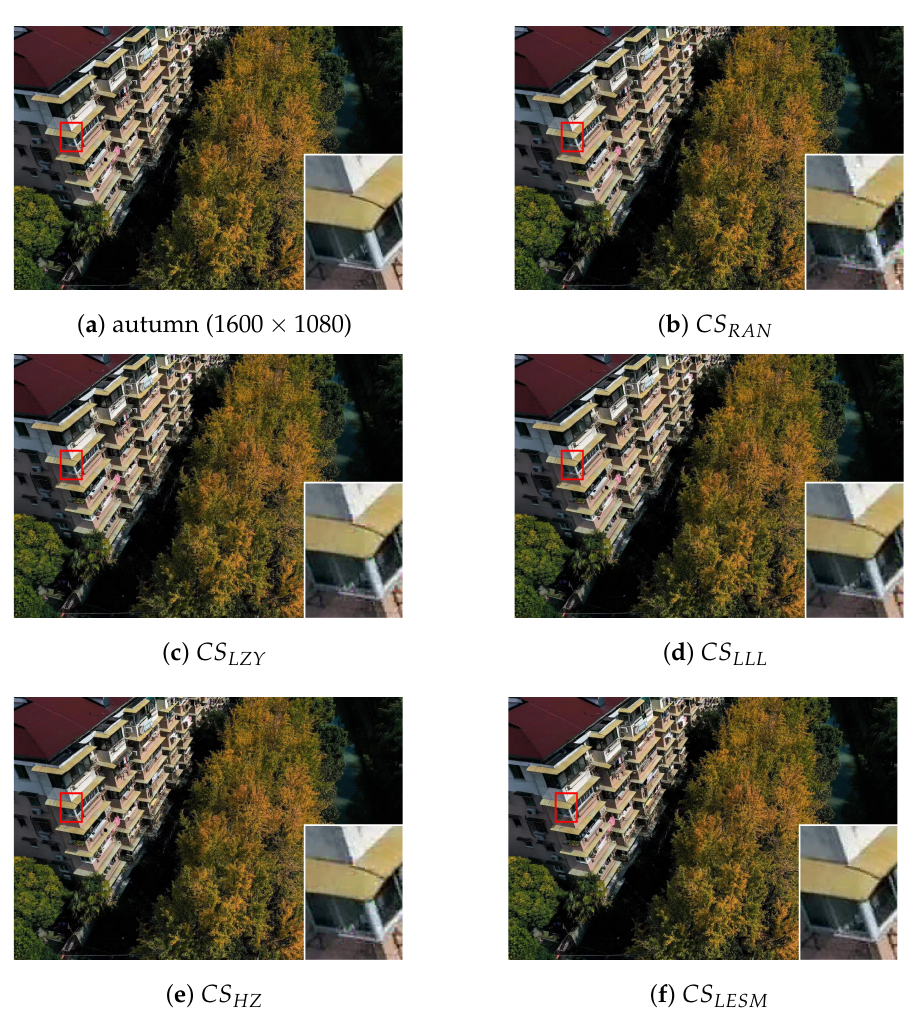
Figure 3. Recovery results for the UAV image "autumn" taken by ourselves with no added noise. ( a ) is the original image, ( b ) is the CS RAN algorithm, ( c ) is the CS LZY algorithm, ( d ) is the CS LLL algorithm, ( e ) is the CS HZ algorithm, and ( f ) is the CS LESM algorithm. Remark 4